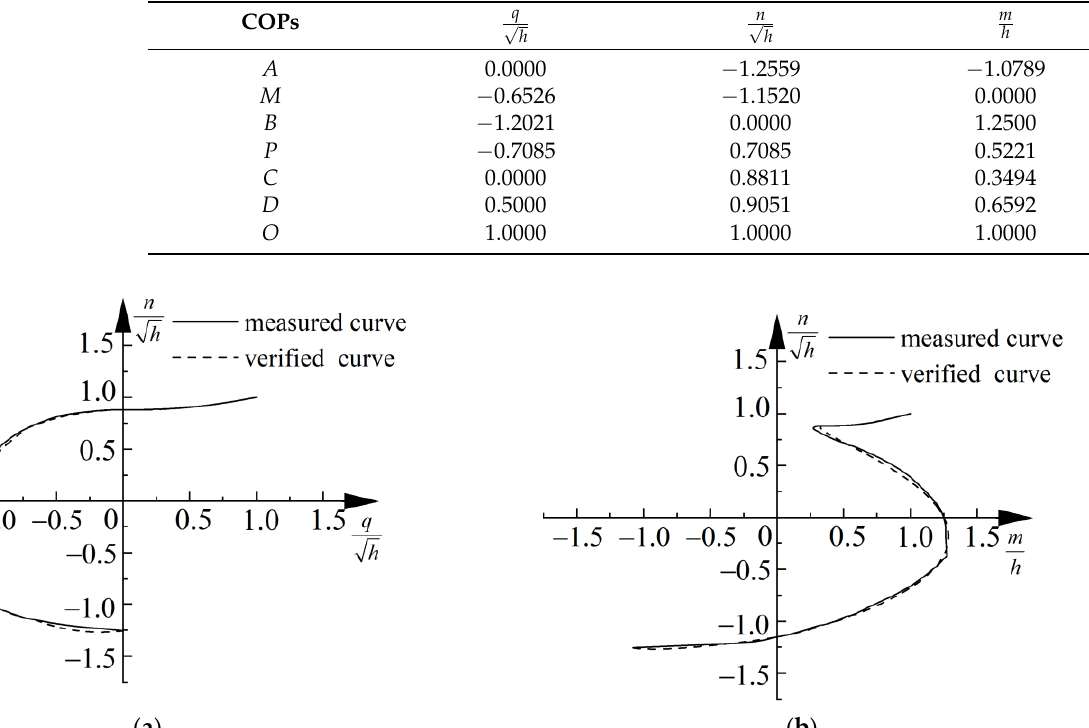
Figure 9. Comparisons of the measured curve and verified curve:( a ) 𝑞 √ℎ⁄ − 𝑛 √ℎ⁄ curve; ( b ) 𝑚 ℎ⁄ − 𝑛 √ℎ⁄ curve. Table 2. The characteristic parameters of COPs on the 𝑞 √ℎ⁄ − 𝑛 √ℎ⁄ and 𝑚 ℎ⁄ − 𝑛 √ℎ⁄ curves cor- responding to n s = 24.6.